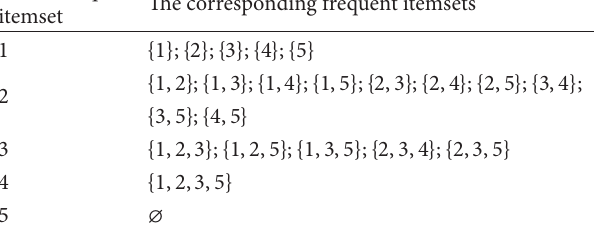
Table 8: The frequent itemsets identified by ECTPPI-Apriori for the Mushroom